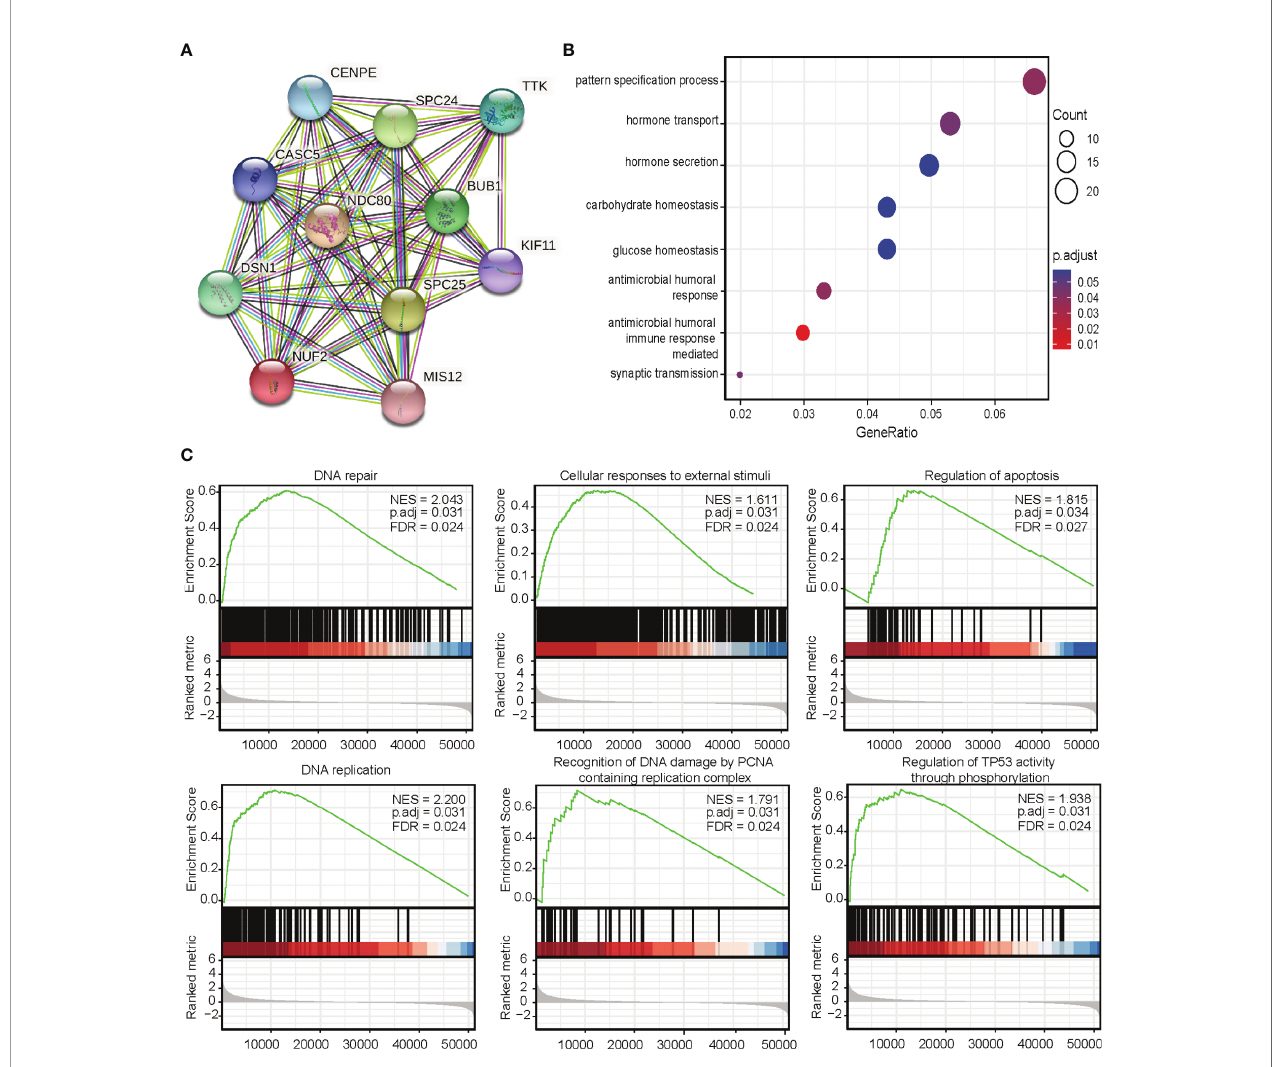
FIGURE 5 | (A) Protein-protein interaction network analysis of NUF2-related genes. (B) Gene Ontology analysis. (C) Gene set expression